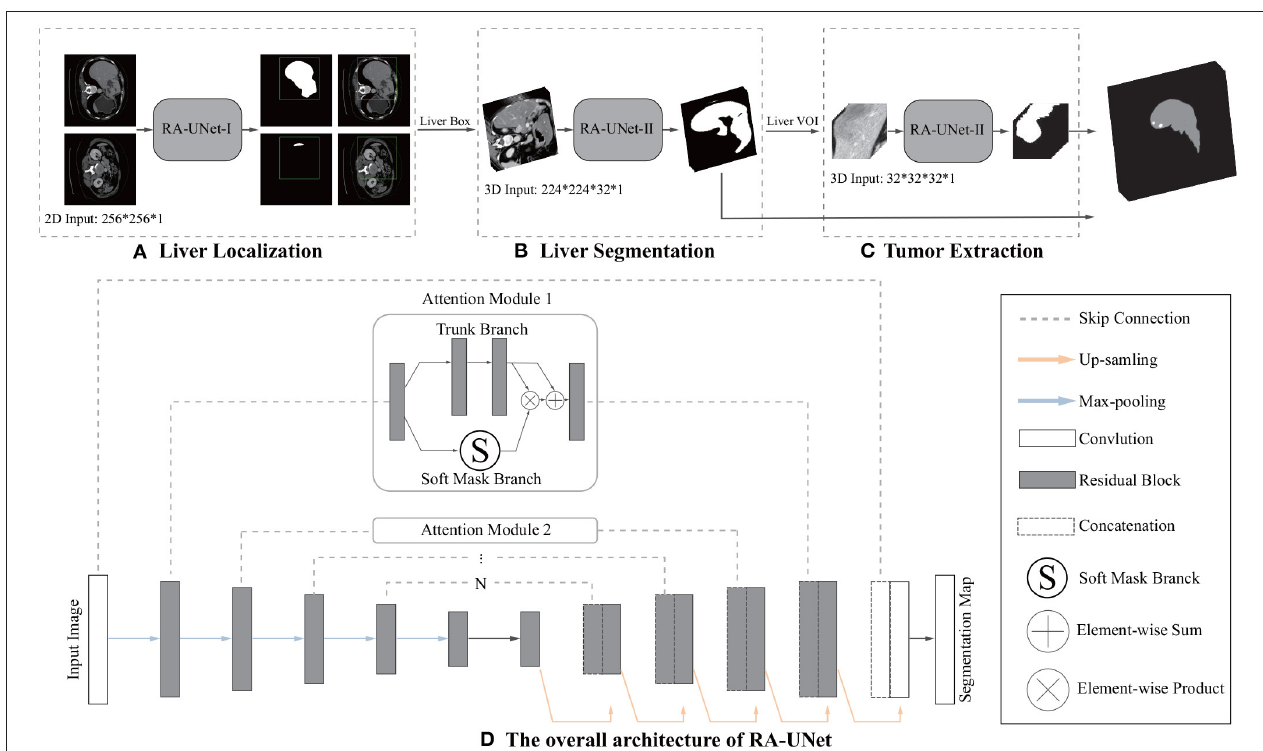
FIGURE 2 | Overview of the proposed pipeline of liver and tumor segmentation. (A) A simple version of 2D RA-UNet (RA-UNet-I) is employed for coarse localization of a liver region within a boundary box. (B) The 3D RA-UNet (RA-UNet-II) is designed for hierarchically extracting attention-aware features of liver volume of interest (VOI) inside the liver boundary box. (C) RA-UNet-II is responsible for an accurate tumor extraction which is inside the liver VOI. (D) The overall architecture of